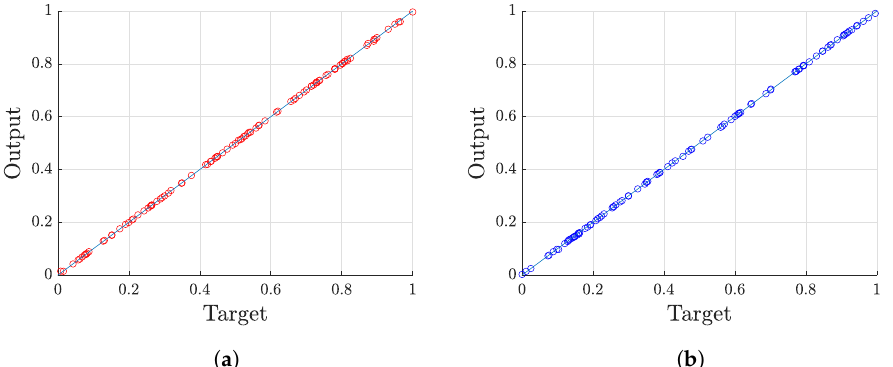
Figure 13. The values on the x-axes are the actual values of the parameters (normalized between 0 and 1), while the values on the y-axes are those predicted by the network. This figure shows the individual fits for the following: ( a ) FDJ of Case B; ( b ) η O of Case B.